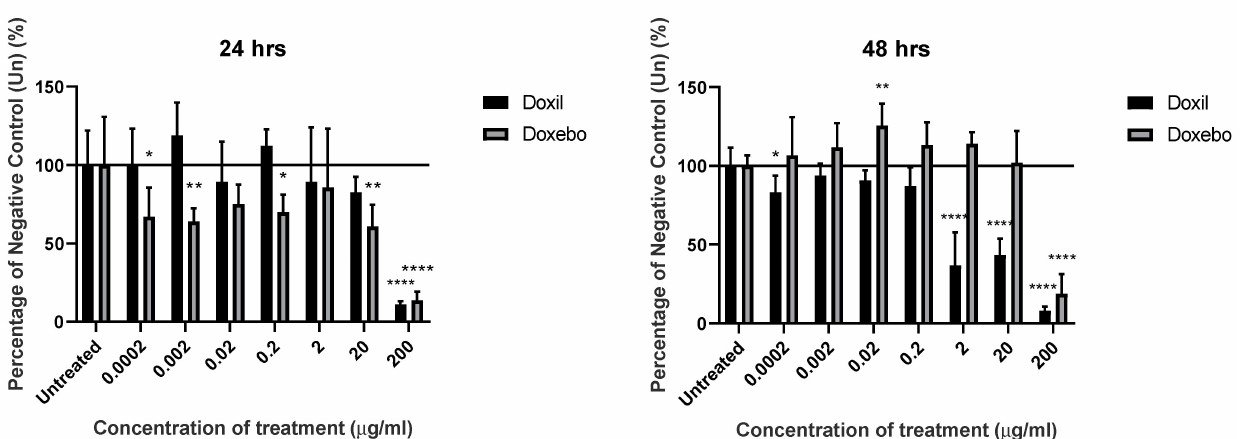
Figure 5. Investigation of cytotoxicity of materials via MTT assay. Level of mean absorbance measured at 570 nm, compared to that of the negative control (untreated), following 24 or 48 h incubation. Values expressed as mean ( n = 8). * denotes p < 0.05, ** denotes p < 0.01, **** denotes p < 0.0001.